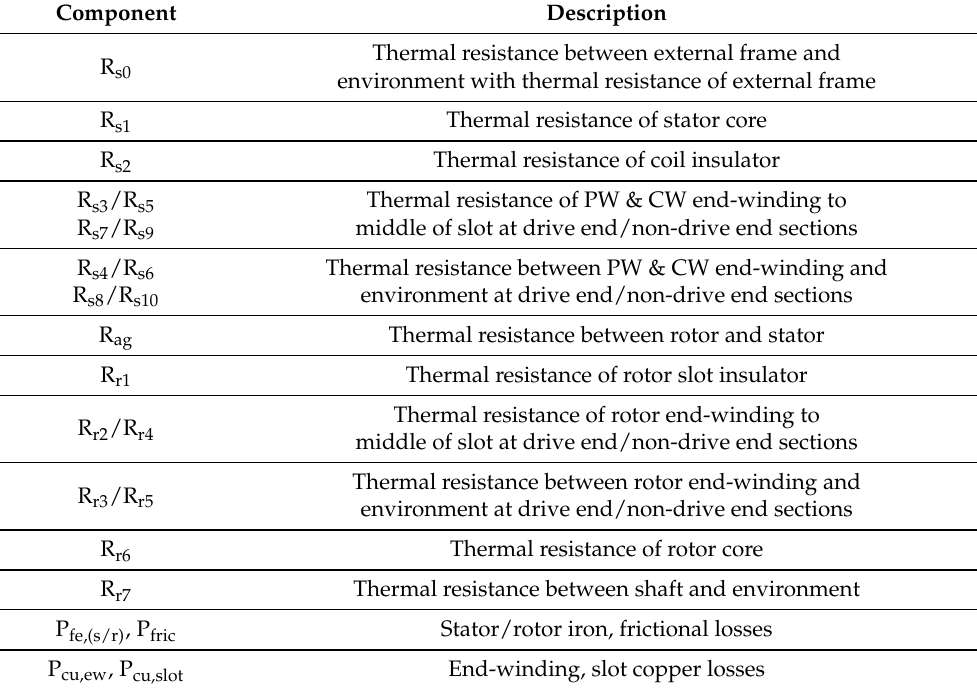
Figure 13. Design process and thermal model in [61]: ( a ) Design flow chart, and ( b ) Radial equivalent thermal network of a BDFM . Table 2. Resistance descriptions in thermal model